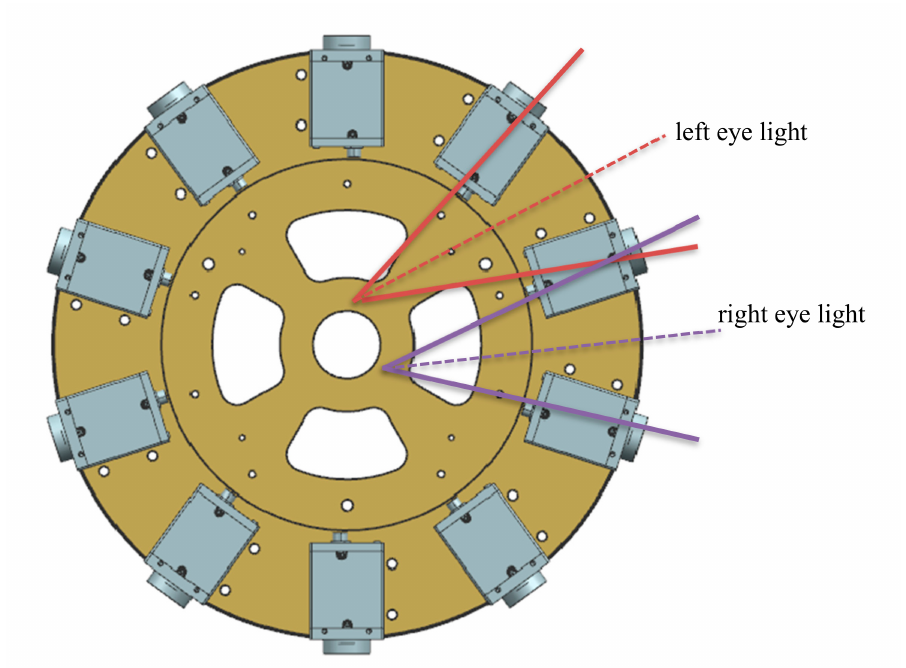
Figure 3. The panoramic stereo camera array based on binocular